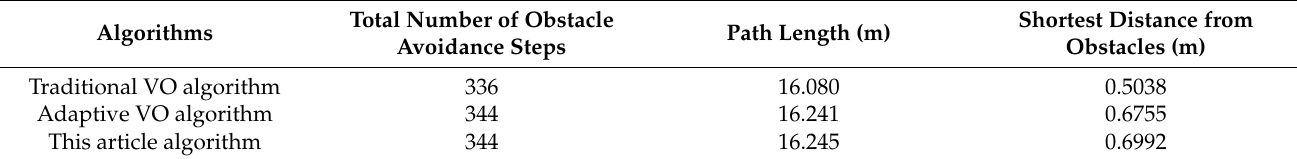
Table 1. Data comparison between traditional methods and the method proposed in this